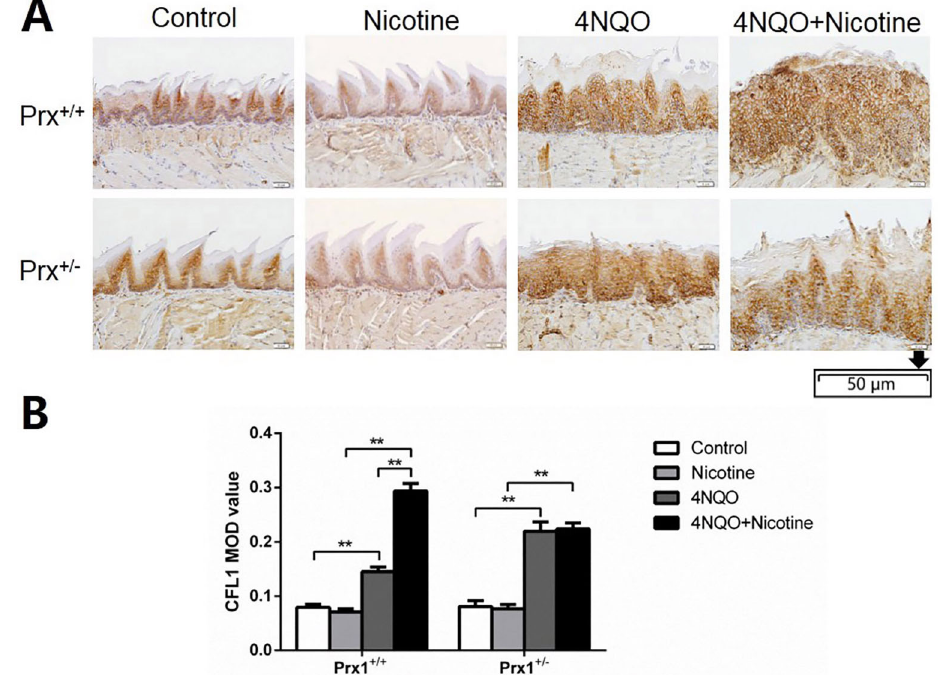
Figure 1. Immunohistochemical analysis of CFL1 in the tongue oral leukoplakia tissues of Prx1 + / + and Prx1 + / – mice. A , Representative immunohistochemistry images of CFL1 ( (cid:3) 200, scale bar 50 m m). B , The integral optical density (IOD)/measurement area (MOD) values are reported as means ± SE. **P o 0.01 (ANOVA). 4NQO: